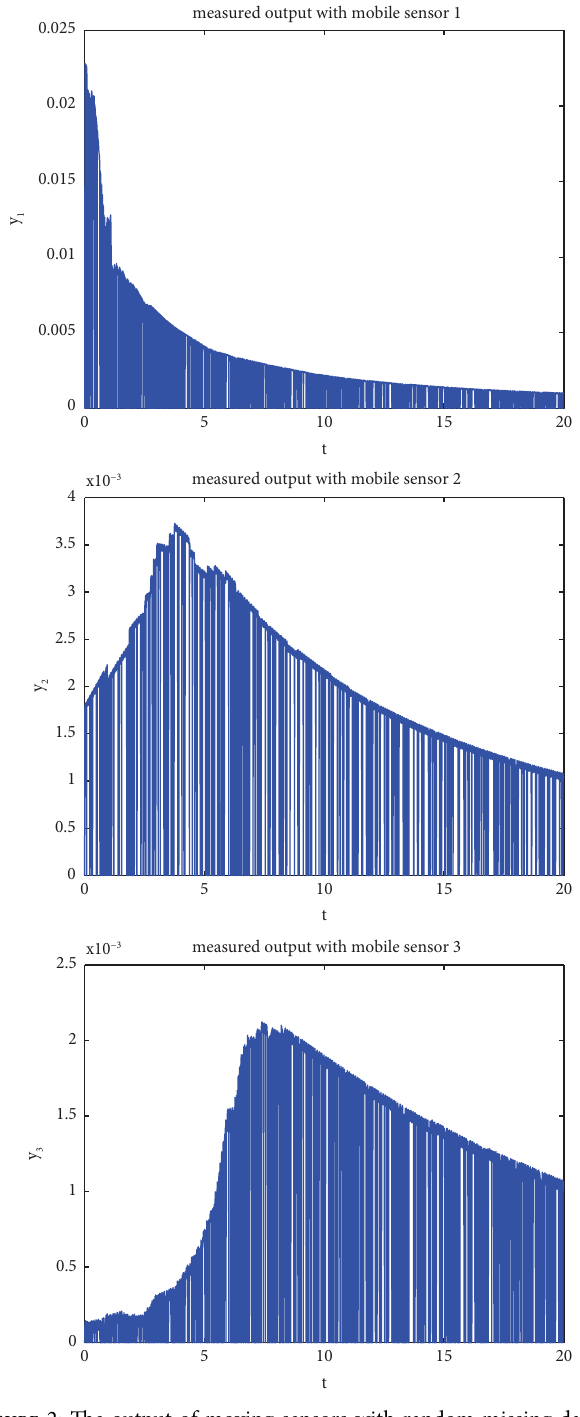
Figure 2: Te output of moving sensors with random missing